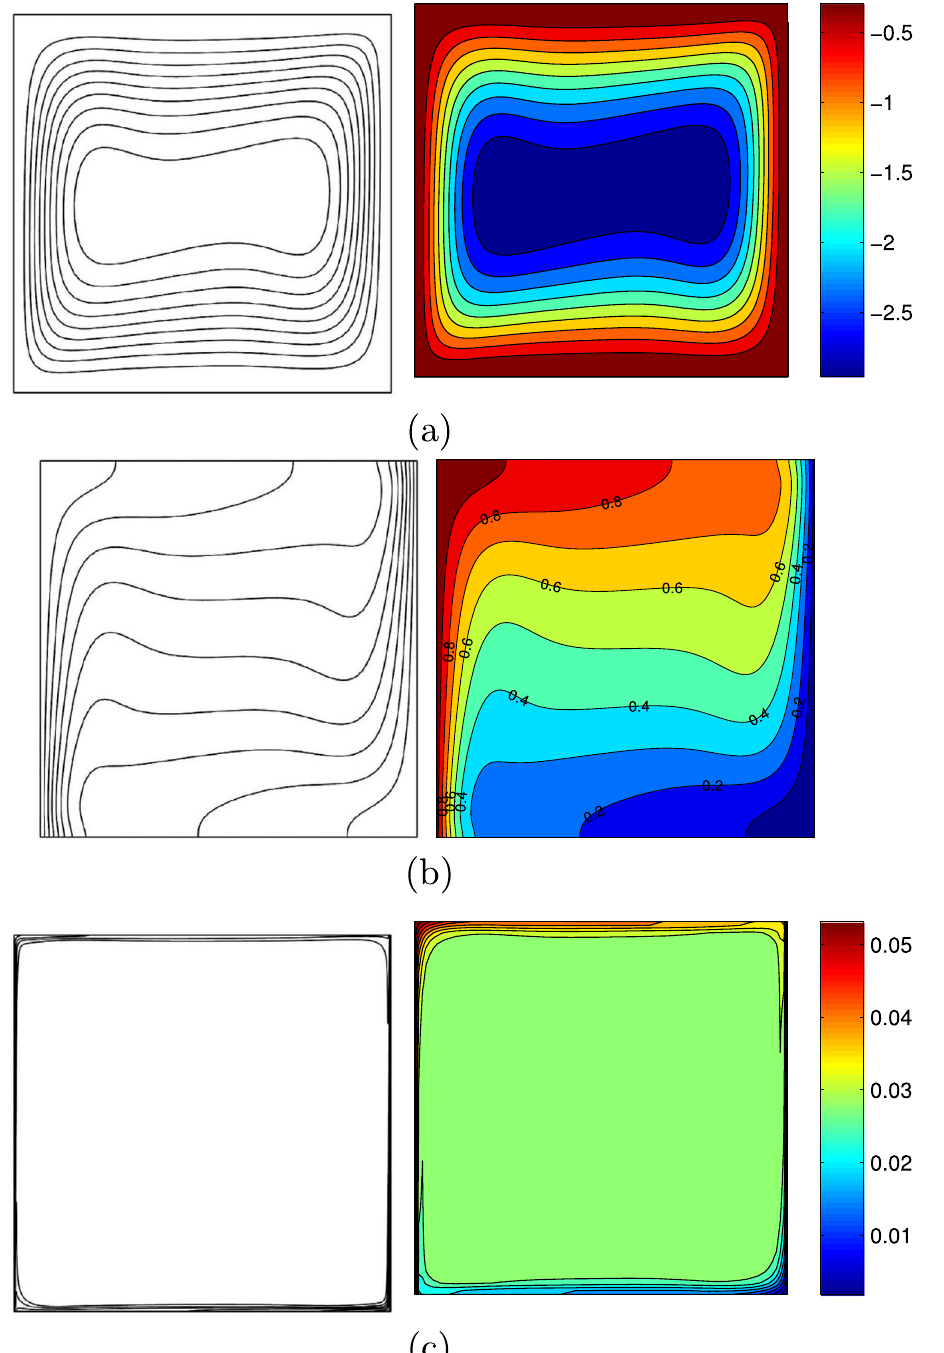
Figure 5. Corcione et al . 46 (left), present study (right) for streamlines ( a ) Isotherms ( b ) and nanoparticle distribution (c ) at Ra = 3.37 × 10 5 , φ = 0.04 and D =